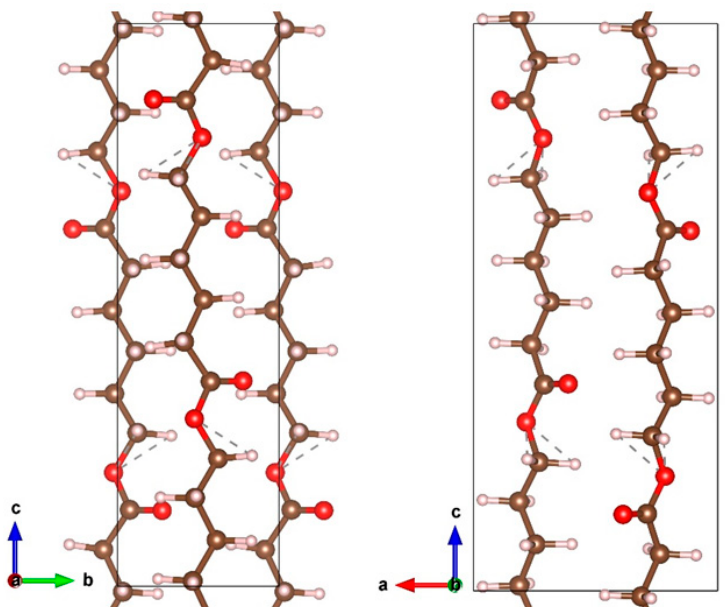
Figure 1. The PCL unit cell. The carbon, hydrogen and oxygen atoms are indicated by brown, gray and red colors.